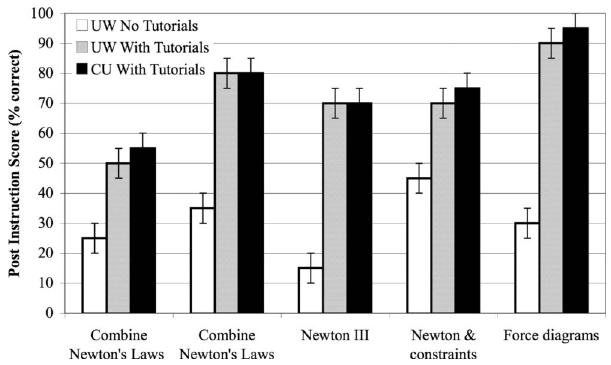
FIG. 1. Post-test results on four published (cid:1) Ref. 13 (cid:2) conceptual questions asked on midterm exams. Results from UW and CU are shown. “No-Tutorial” scores are shown for courses at UW only. Following UW reporting practices, our results are rounded to the nearest